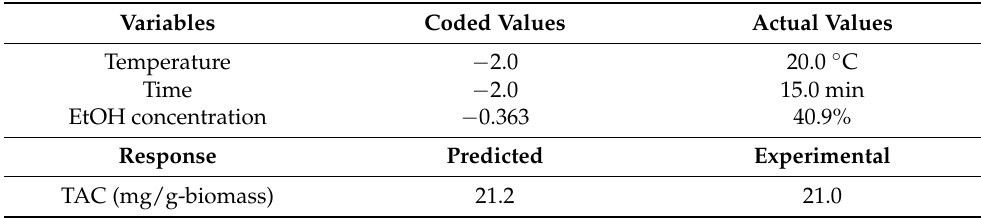
Table 4. Numerical optimization of anthocyanin extraction from elderberry.